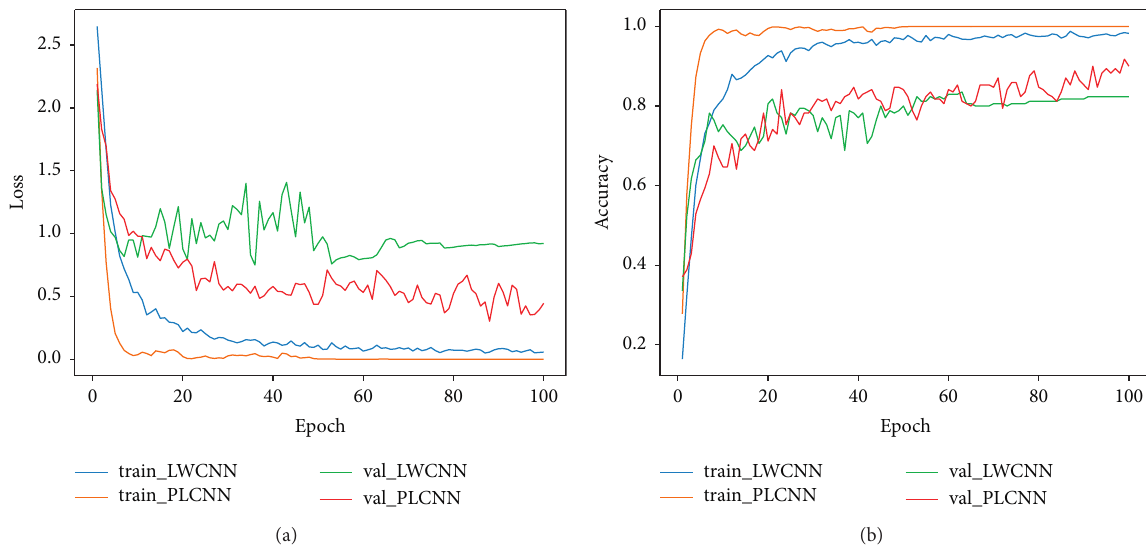
Figure 13: Loss function trend chart and precision change trend chart for Exercise B: (a) loss tend; (b) accuracy